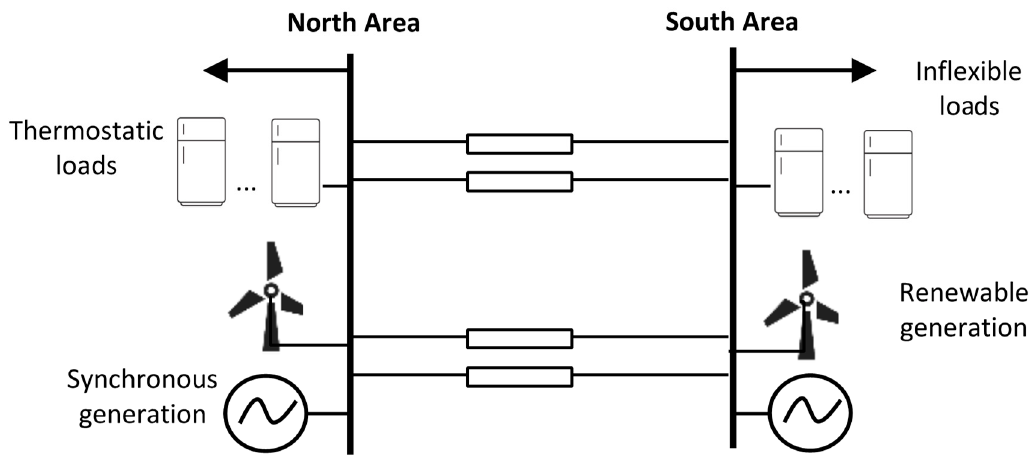
Figure 1. Schematics of the two-areas power system model.